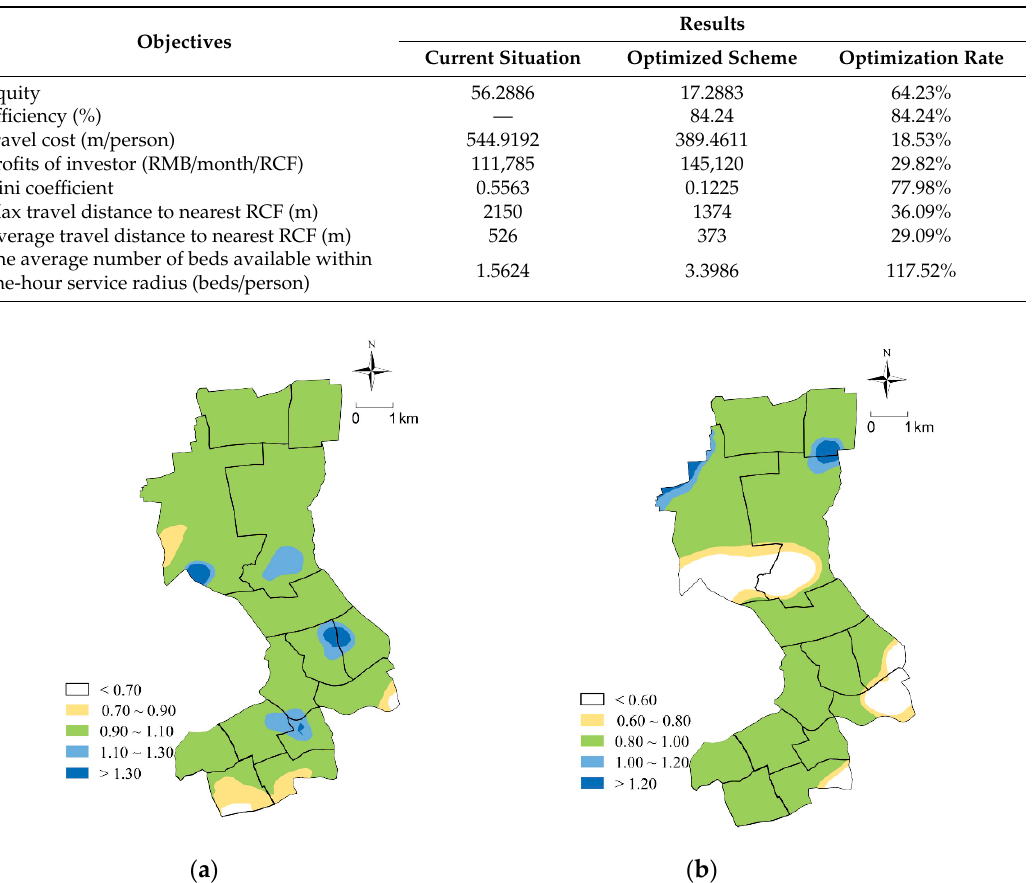
Table 4. Comparison of optimized results with the current situation.